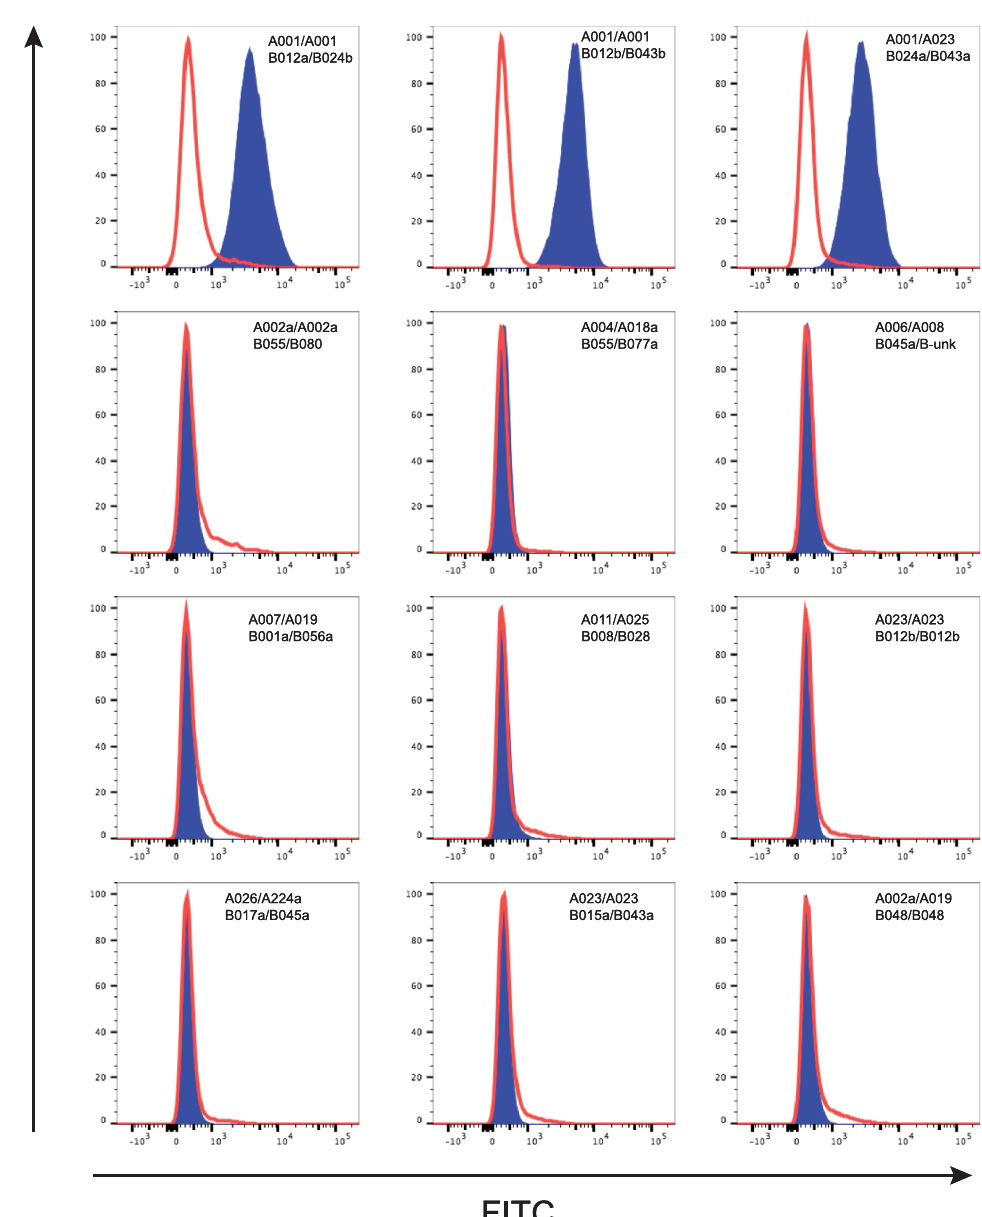
Fig 5. Assessing the specificity of P12 against a panel of PBMC. PBMC from Mamu-A1 * 001-positive (top row) and -negative (bottom three rows) rhesus macaqueswere stainedwith P12 (blue traces) or non-specific mouse Ig (red traces). Cell-boundP12 was detected with FITC-labeled anti-HA antibody and control antibody with FITC-labeled goat anti-mouse Ig. The MHC haplotypes from which the PBMC were isolatedare providedin the upper right corner or each